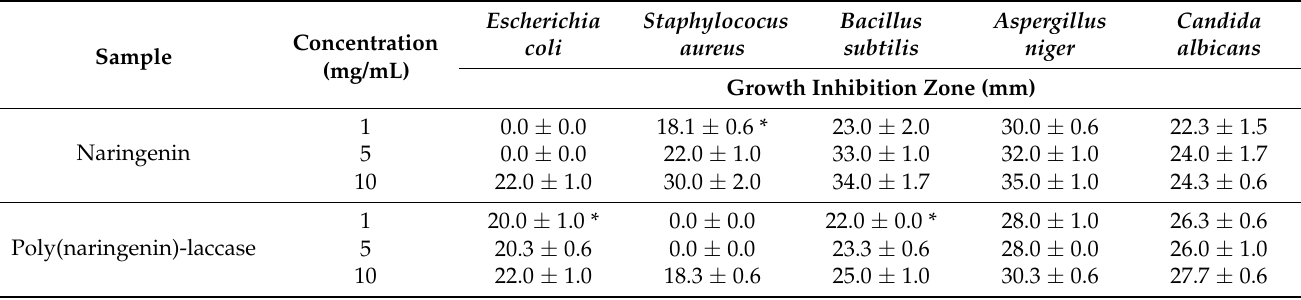
Table 5. Antimicrobial activity of naringenin and